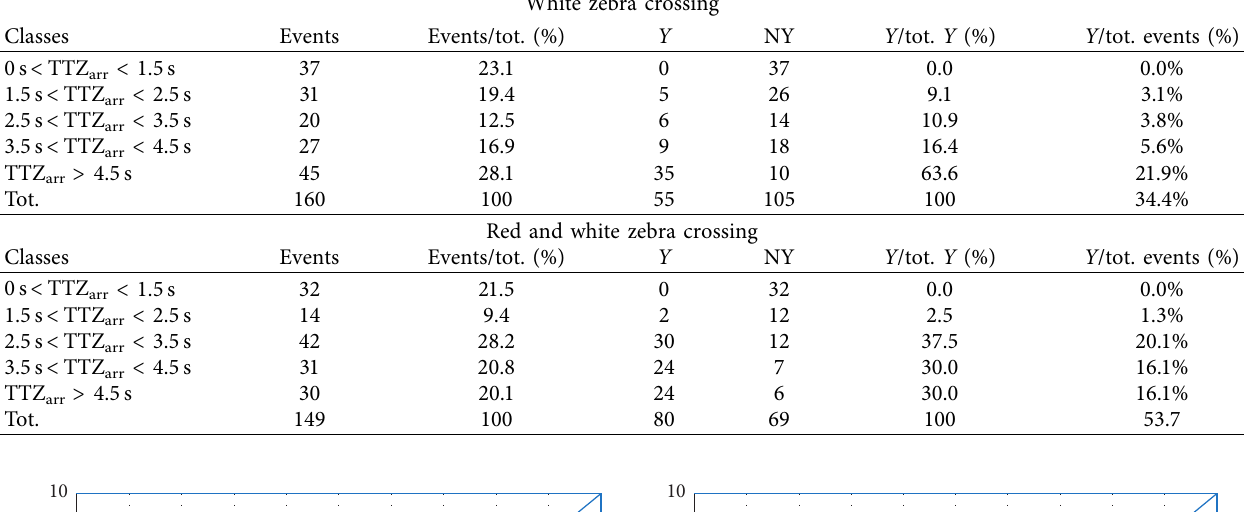
Table 2: Analysis of yielding referred to TTZ arr classes of the white and red and white zebra crossing.